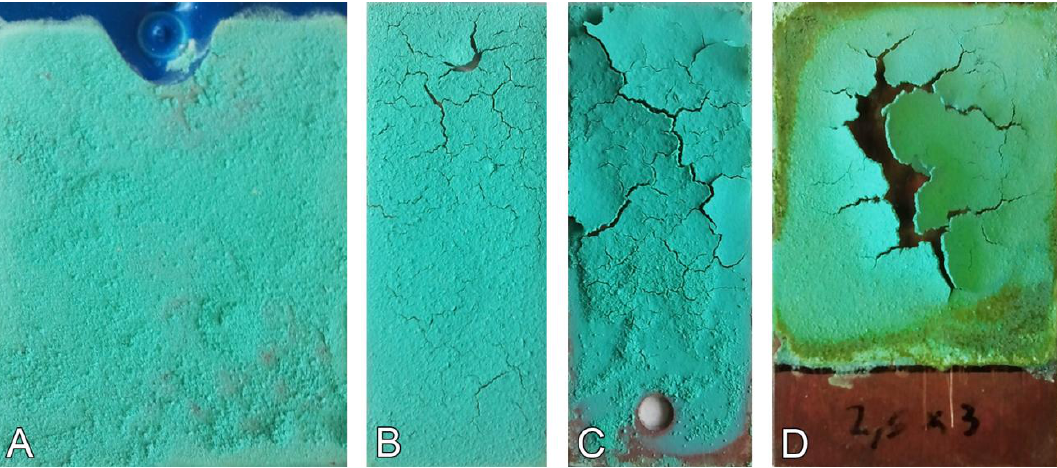
Figure 5. Brochantite patinas with increasing thickness ( A ) > ( B ) > ( C ) > ( D ) (sensors max. length: 60